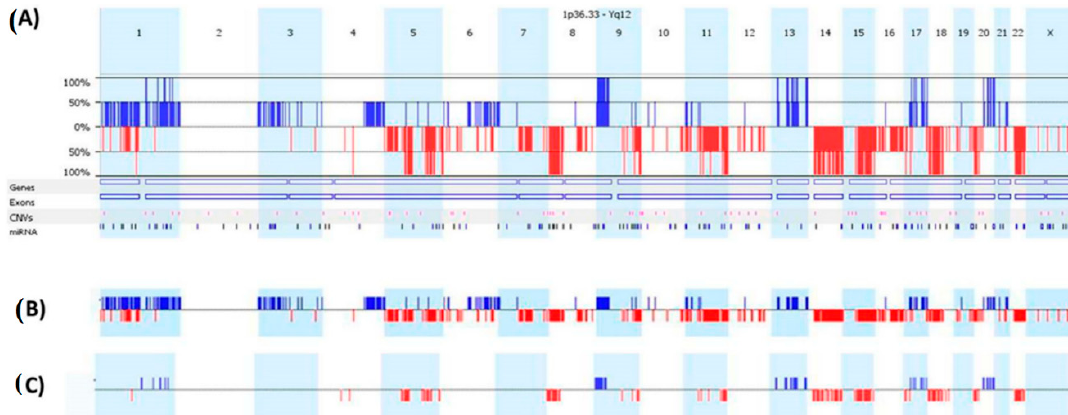
Figure 1. Copy number aberrations in CRC stage II using the first analytical approach STAC ( A ), which compares the chromosomal copy numbers found in metastatic CRC with non-metastatic CRC; and the second analytical approach; the survival predictive algorithm ( B ), which identifies chromosomal copy number gains associated with reduced disease-free survival; ( C ) shows the frequencies of the aberrations in the two approaches and identifies CNA common to both methods (100%). Each column represents a chromosome with blue bars indicating copy number gains and red bars copy number losses.